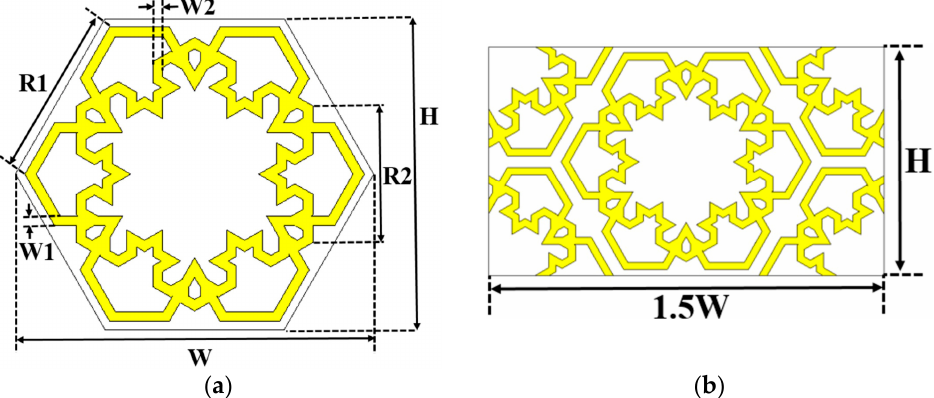
Figure 1. The geometry of the MFSS. ( a ) Unit cell of the MFSS, and ( b ) triangular lattice arrangement. (H = 7.01 mm, P = 8.09 mm, R1 = 3.84 mm, R2 = 3.08 mm and W1 = W2 = 0.22 mm).